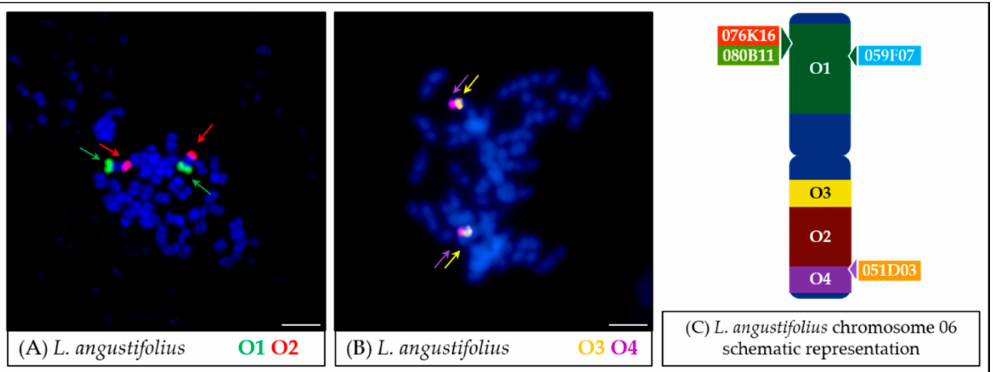
Figure 3. Fluorescence in situ hybridization (FISH) mapping of oligonucleotide probes in mitotic chromosomes of L. angustifolius . The positions of individual probes are marked by arrows. Probe colors are as follows: green (O1, Lang06 arm ( A ), red (O2, Lang06 arm ( B )), yellow (O3, pericentromeric region ofLang06armB)andpurple(O4, telomereregionofLang06armB).Scalebar: 5 µ m. ChromosomeLang06 schematic representation ( C ), showing the positions of aligned particular oligonucleotide-based or BAC-based probes, was not drawn to